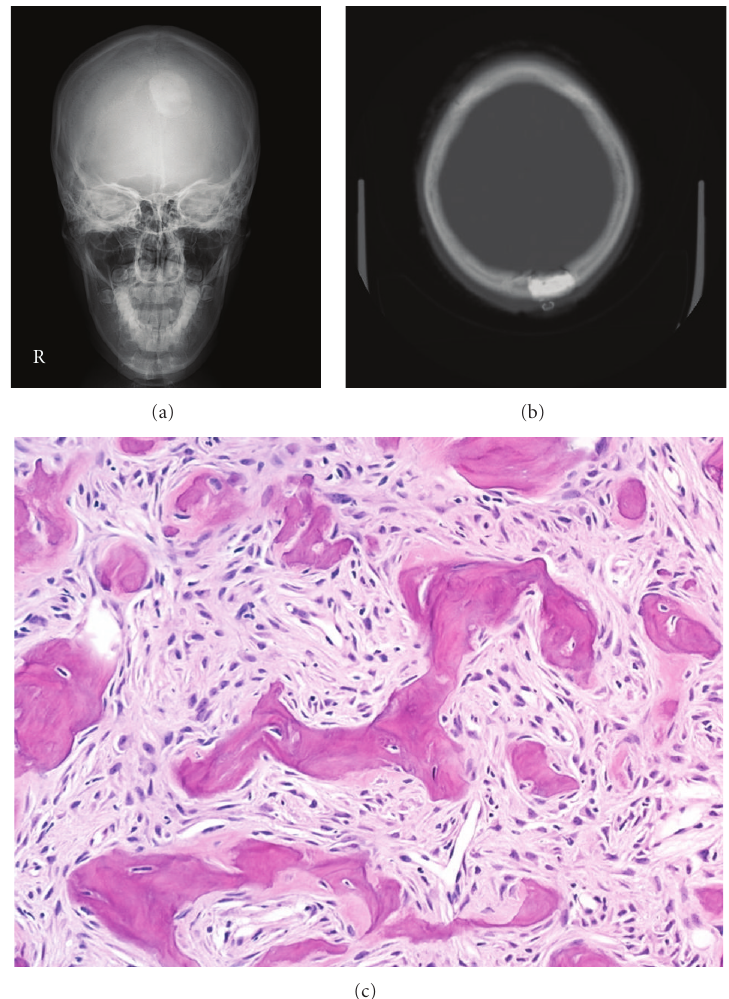
Figure 3: Postoperative AP view of skull xp (a) and bone image with head CT (b) showing complete resection of the tumor and excellent re- modeling of the skull deficit using calcium phosphate paste. Microscopic view of the intraoperative biopsied specimen (c, H&E stain, × 200). The lesion was composed of irregularly shaped trabeculae of woven bone with calcification in a background of fibrous tissue. There were no osteoblasts on the surface of the trabeculae. These histological findings were indicative of fibrous